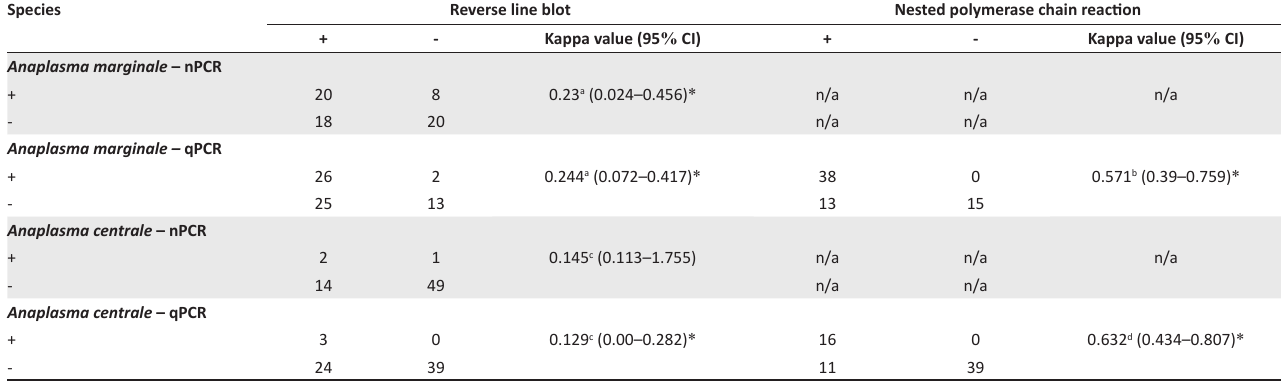
TABLE 2: Comparison of reverse line blot, nested polymerase chain reaction and quantitative polymerase chain reaction assays in the detection of Anaplasma marginale and Anaplasma centrale in cattle samples in South Africa. Species Reverse line